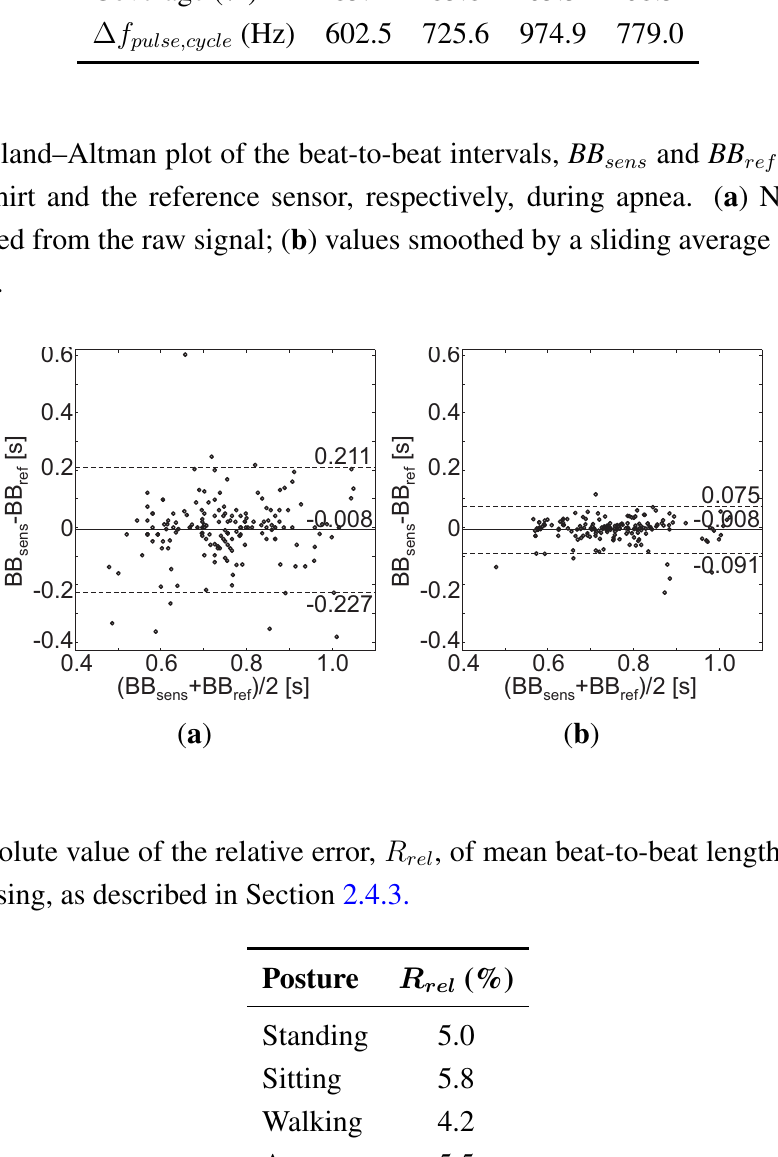
and BB , recorded by sens ref